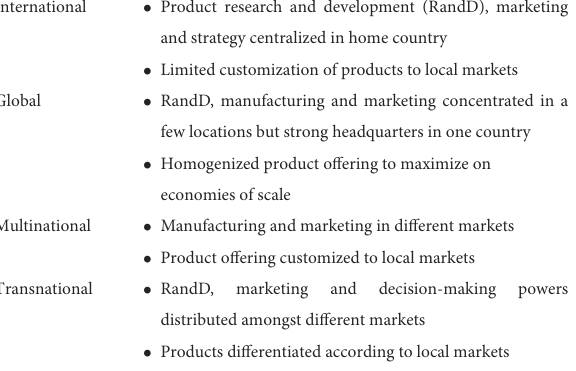
TABLE 2 Company business strategies (Bartlett and Ghoshal, 1998; Hill,